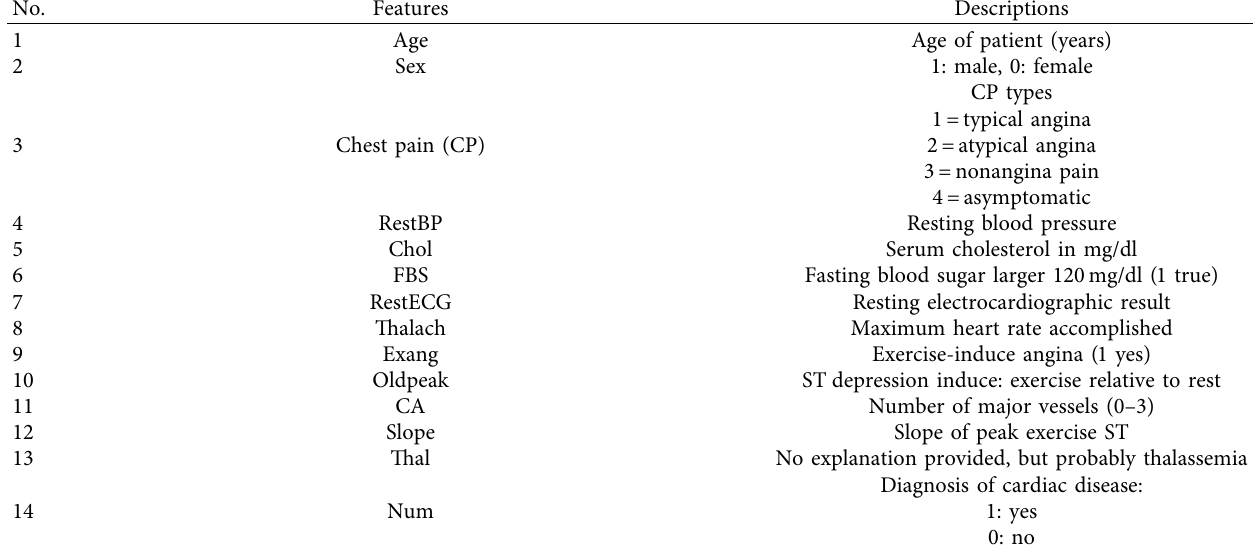
Table 1: Heart disease dataset